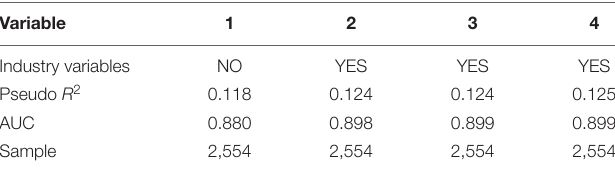
TABLE 1 | Variable description